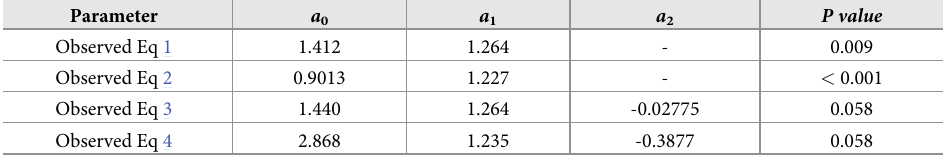
Table 5. Parameter of predictive equation for drug dialyzabilities in HD patients using single or multiple linear regression model.